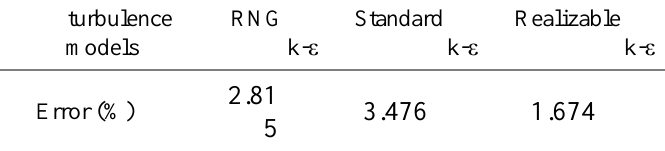
in a distance of 3 cm x from the pier